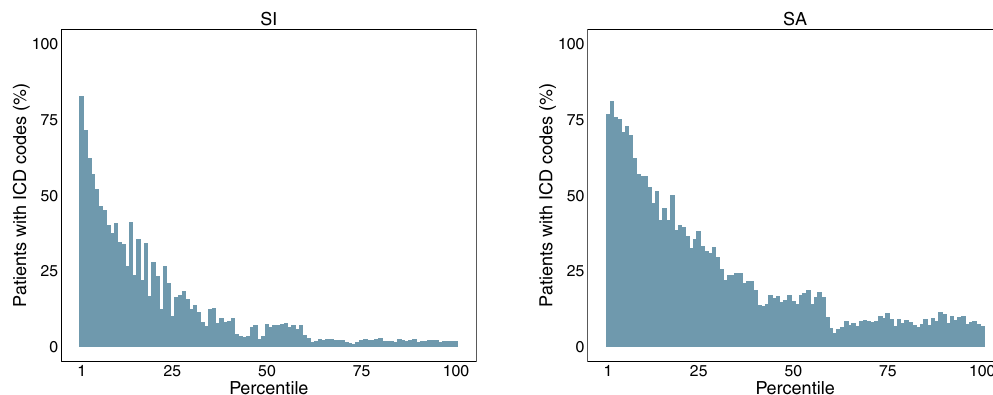
Figure 2. Distribution of patients with ICD codes across the ranked lists of suicidal ideation (SI) and suicide attempt (SA) patients. For each retrieved list, patients were first ordered by their similarity score (or rank position) such that the most relevant ones are ranked at the top of the list. Each list was then split into 100 equal groups (percentiles) with the first and last percentiles representing the highest and lowest ranked patients, respectively. The percent of patients with relevant ICD codes was computed for each percentile.